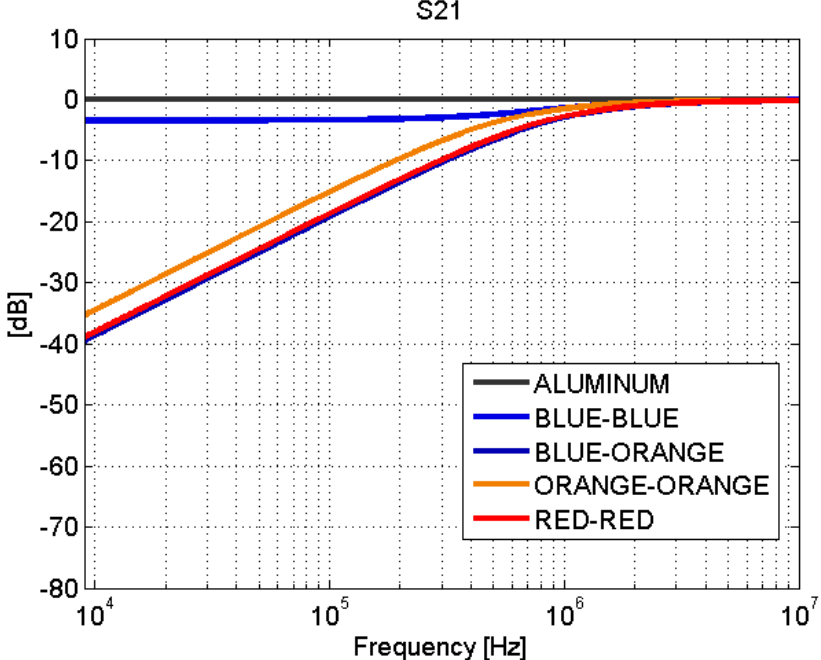
Figure 9. Scattering parameters test: S 21 . Adhesive joints.